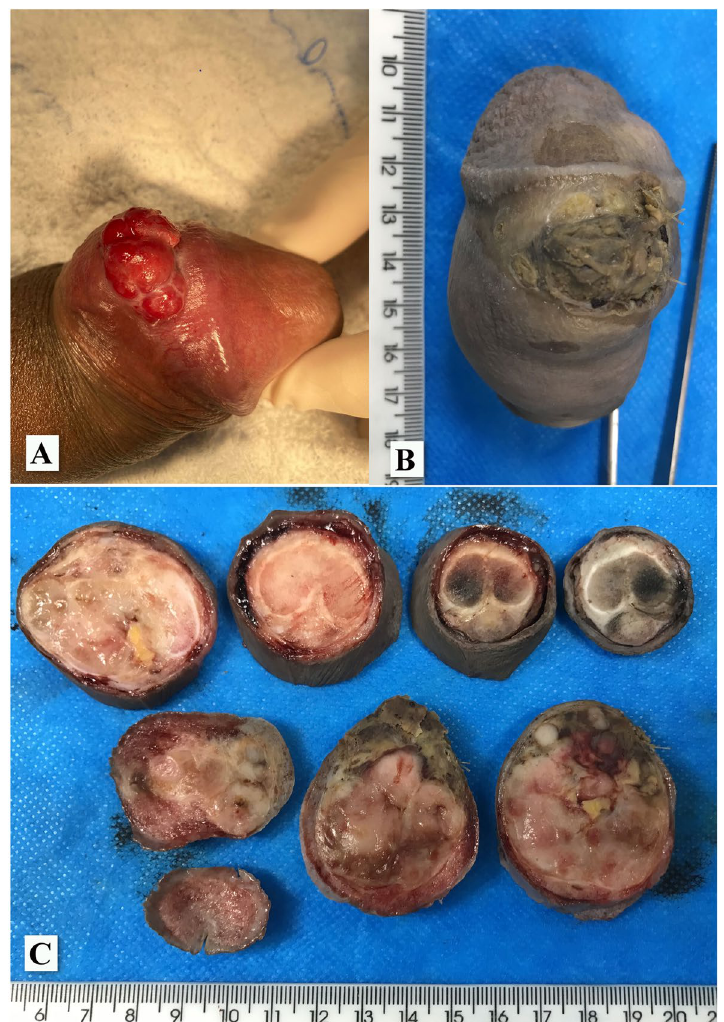
Fig. 1 Gross appearance of penile osteosarcoma. Clinical appearance before surgery ( A ) and after resection and formalin fixation ( B ). Cut surface of the specimen. Fleshy tumor involving corpora cavernosa and corpus spongiosum. Upper left section shows uninvolved margin and bottom right shows the uninvolved distal glans ( C